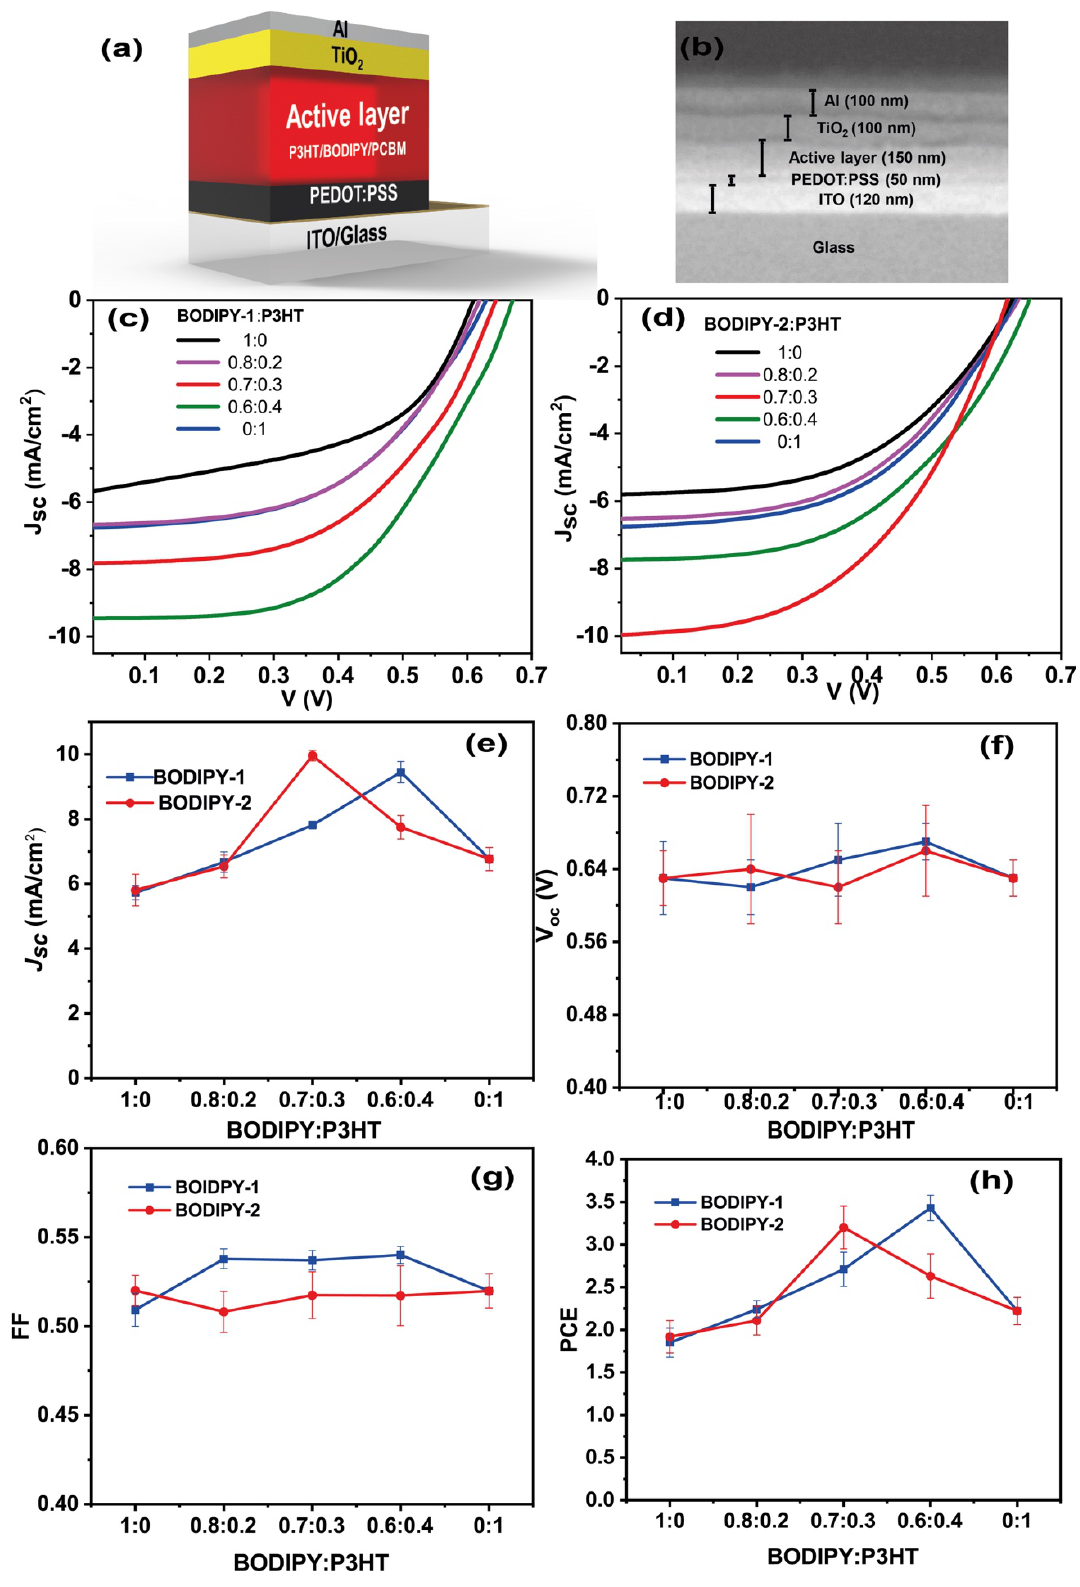
Figure 3. ( a ) Device architecture, ( b ) SEM cross-section of a solar cell, ( c , d ) J–V curve of BODIPY-1 :P3HT:PCBM and BODIPY-2 :P3HT:PCBM ternary solar cells, and ( e – h ) Photovoltaic parameters (J sc , V oc , FF and PCE) plotted against the weight ratio of BODIPY and P3HT.